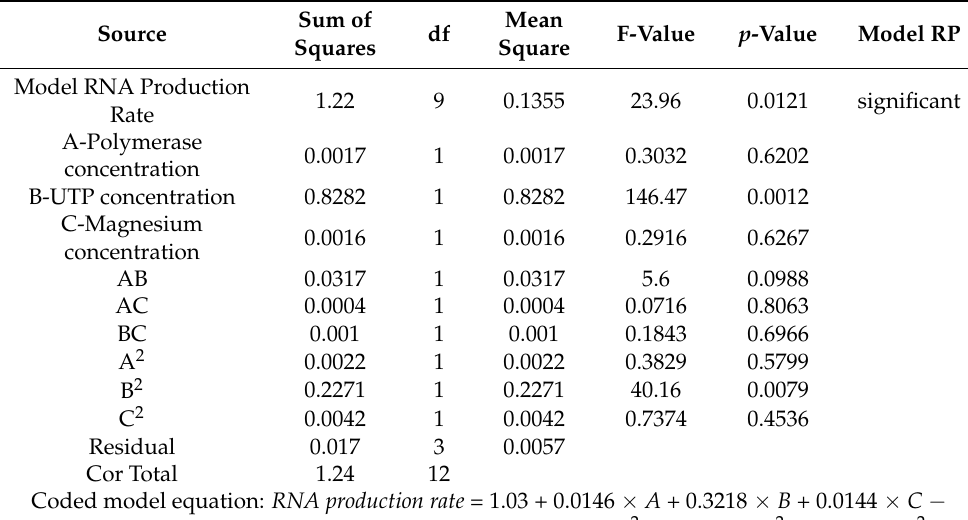
Table 6. ANOVA of RNA production rate exploring the design space of the factorials polymerase and UTP concentration.